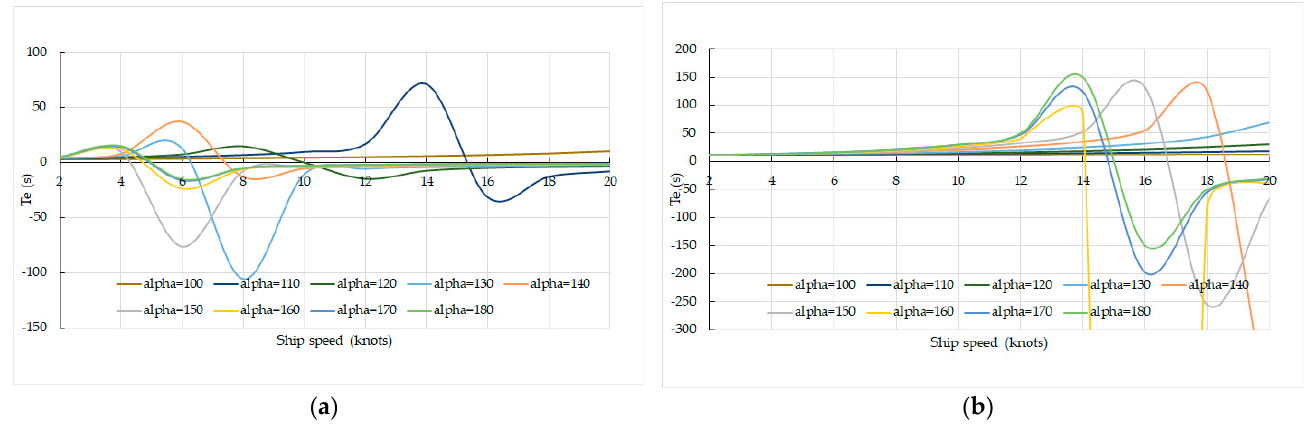
Figure 13. The Te for different combinations of velocities and α angles. ( a ) Tw = 3 s and ( b ) Tw = 10 s.